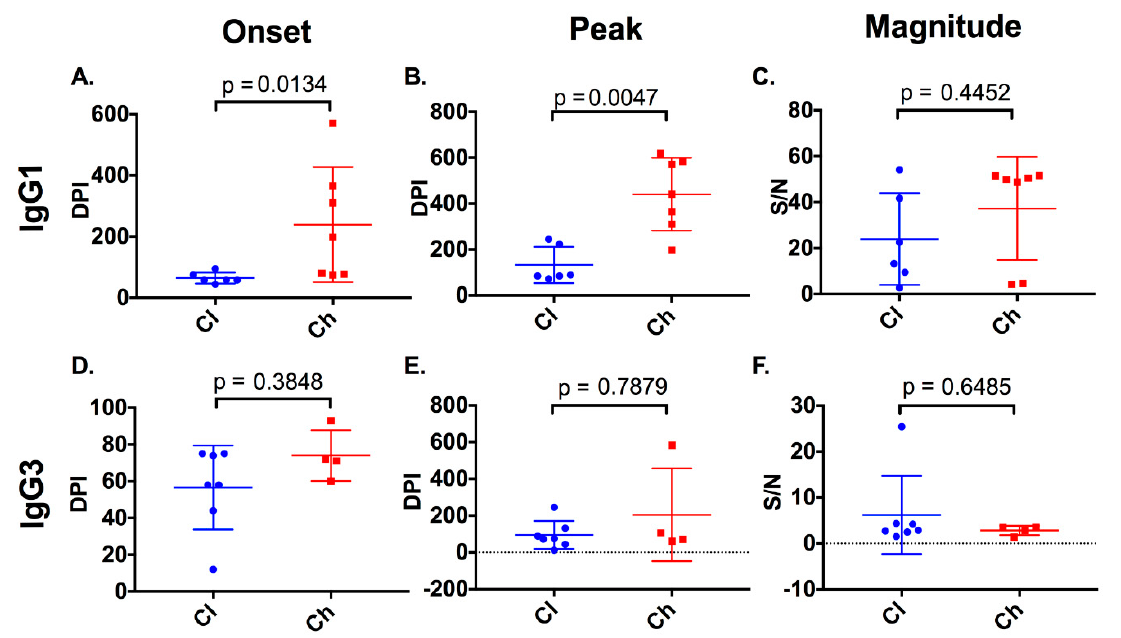
Figure 5. Timing and magnitude of anti-E2 IgG subclasses in clearer and chronic progressor subjects. The timing (days post infection (DPI)) and magnitude (signal / noise (SN)) of anti-E2 IgG1 and IgG3 responses were assessed in clearers and chronic progressors for the first detectable anti-E2 IgG1 ( A ) and IgG3 ( D ) responses, the timing of the peak anti-E2 IgG1 ( B ) and IgG3 ( E ) responses, and the magnitude of the peak anti-E2 IgG1 ( C ), IgG3 ( F ) responses.